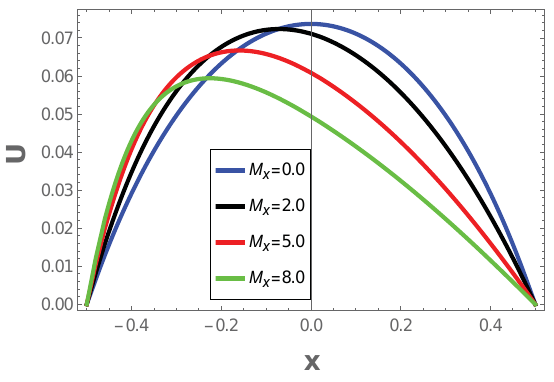
Figure 5: The profile of velocity with Hartmann numbers 0 (top curve), to 8 (bottom